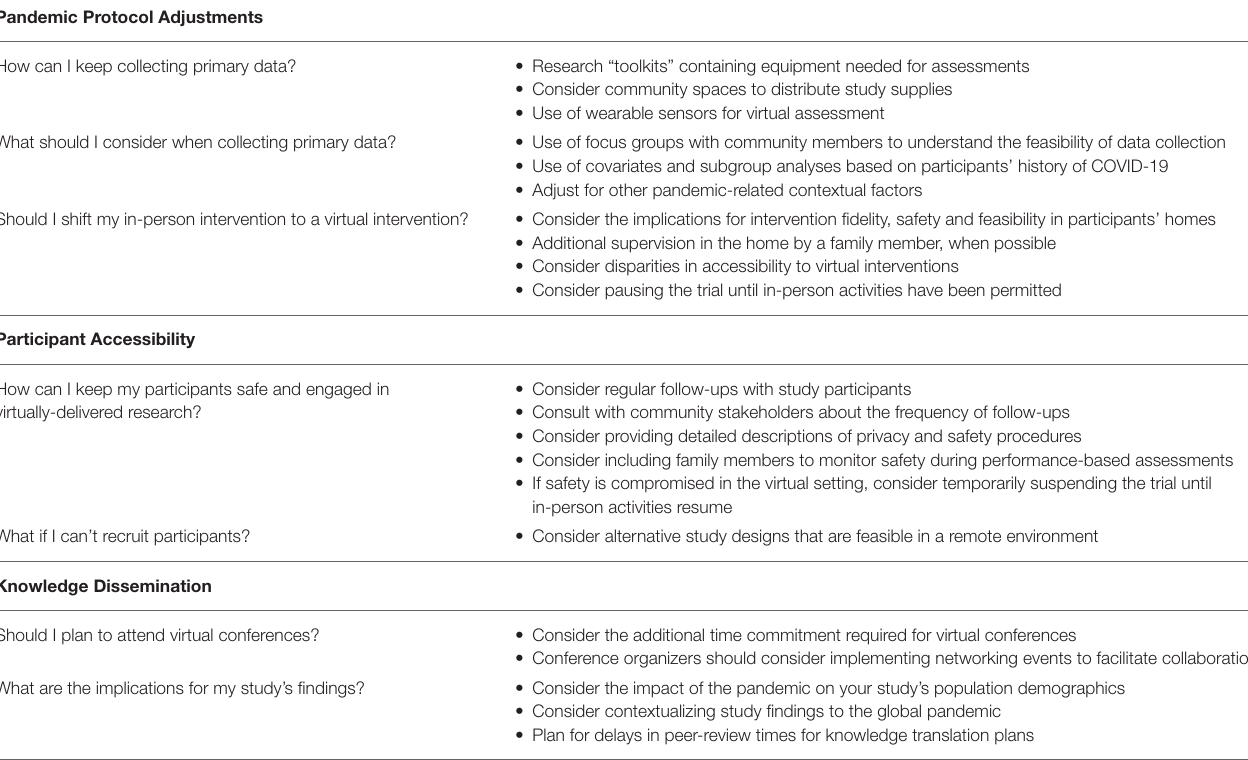
TABLE 1 | Summary of workshop